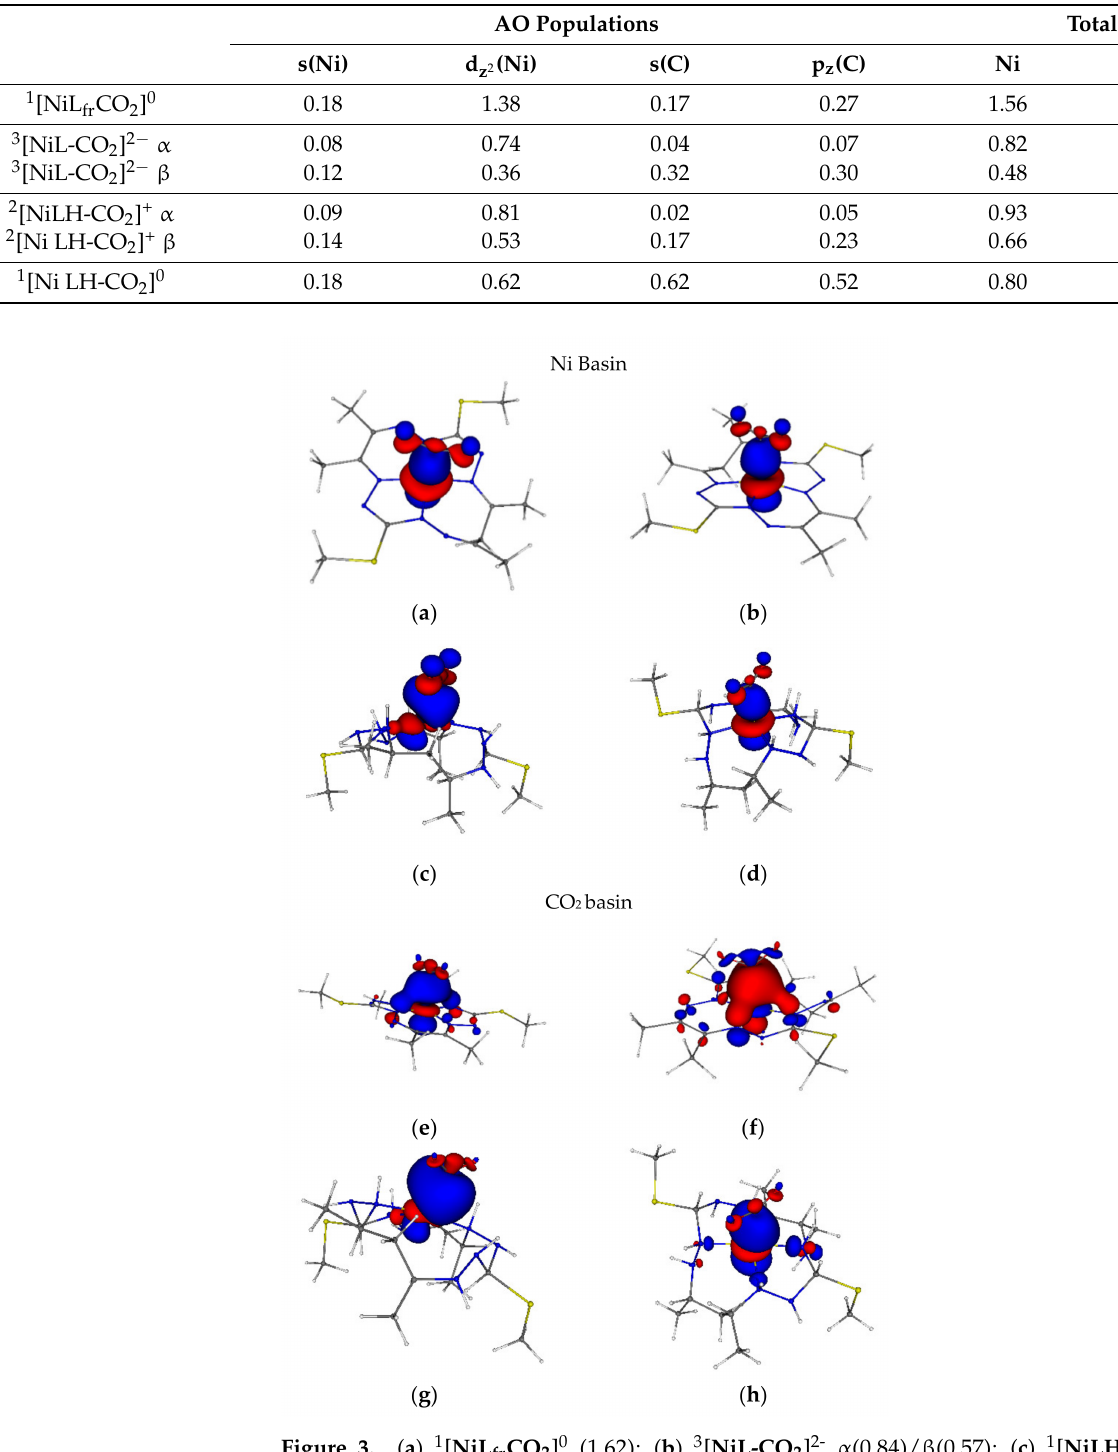
Table 4. B3LYP/6-311G* LOC AO populations and atomic total